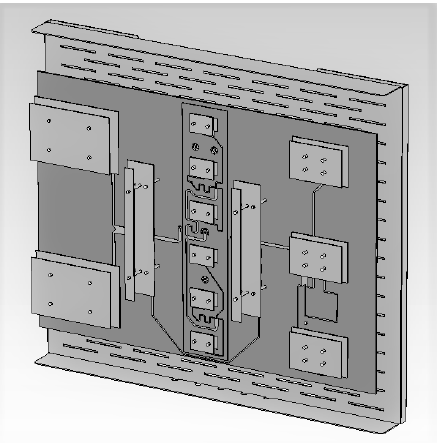
Fig. 1. Appearance of the antenna